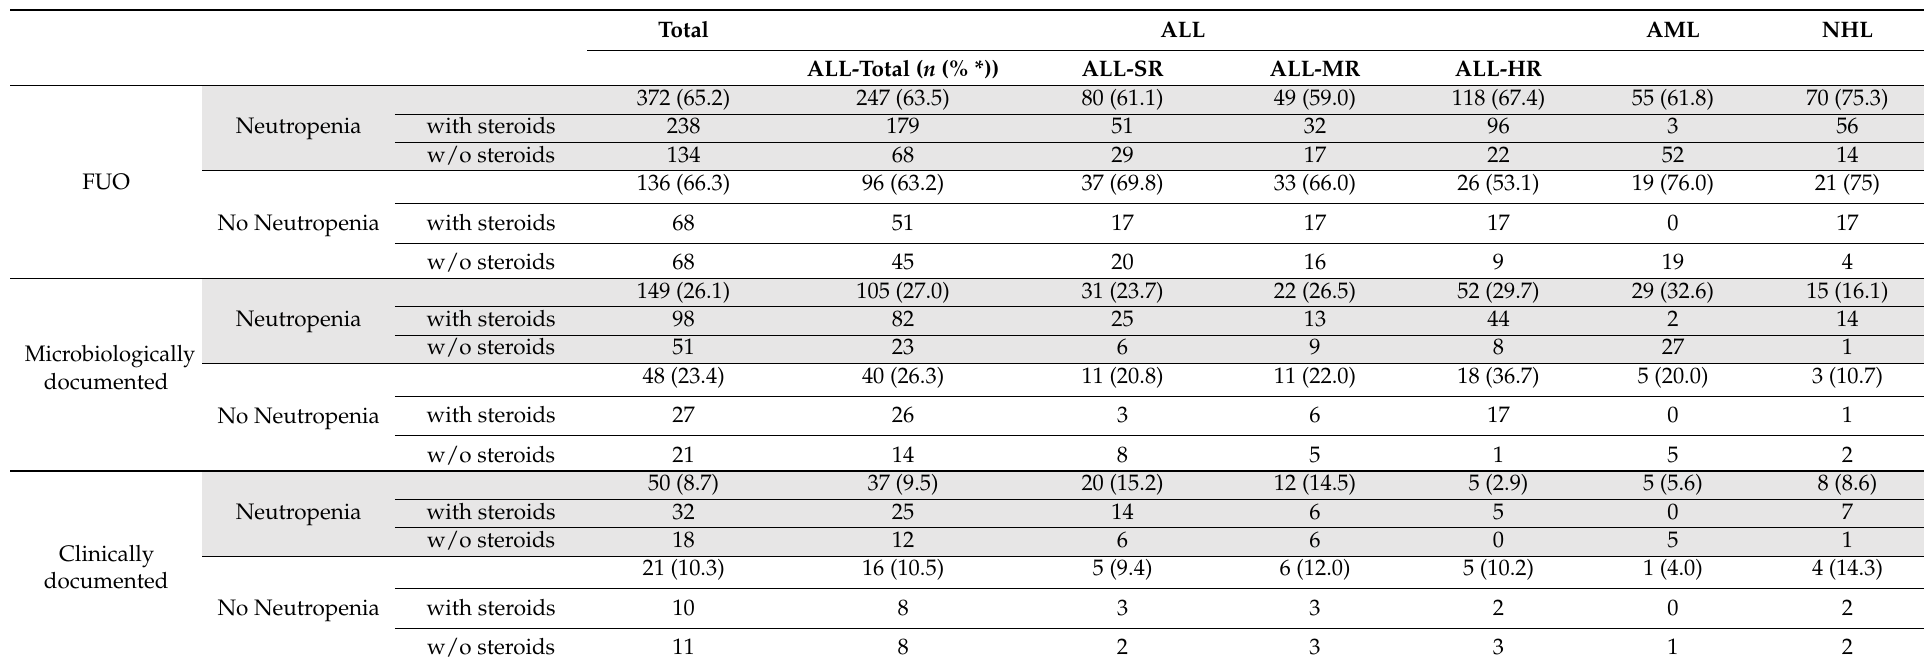
Table 1. Fever of unknown origin, microbiologically documented and clinically documented infections in children with acute lymphoblastic leukemia, acute myeloid leukemia, and non-Hodgkin